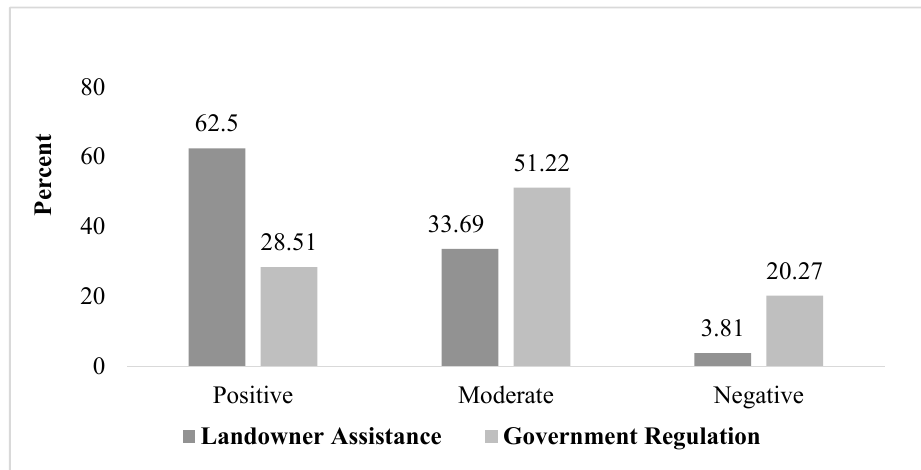
Figure 3. Percent of survey respondents and attitudes towards government involvement on private forest lands through landowner assistance programs and regulations ( n = 656).